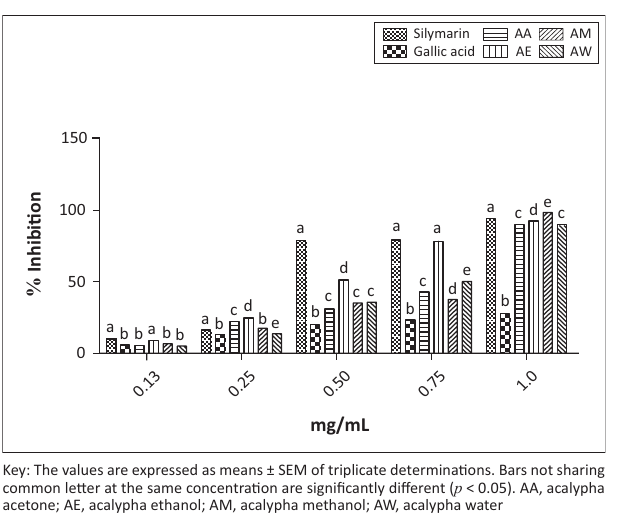
FIGURE 1: 1,1-Diphenyl-2-picryl-hydrazyl scavenging potential of leaf extracts of Acalypha godseffiana .